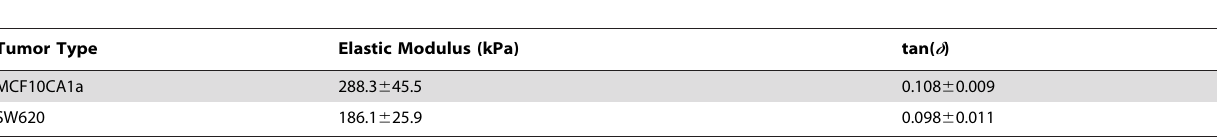
Table 1. Experimental measurements for the elastic modulus and tan( d ) of the two tumor types.